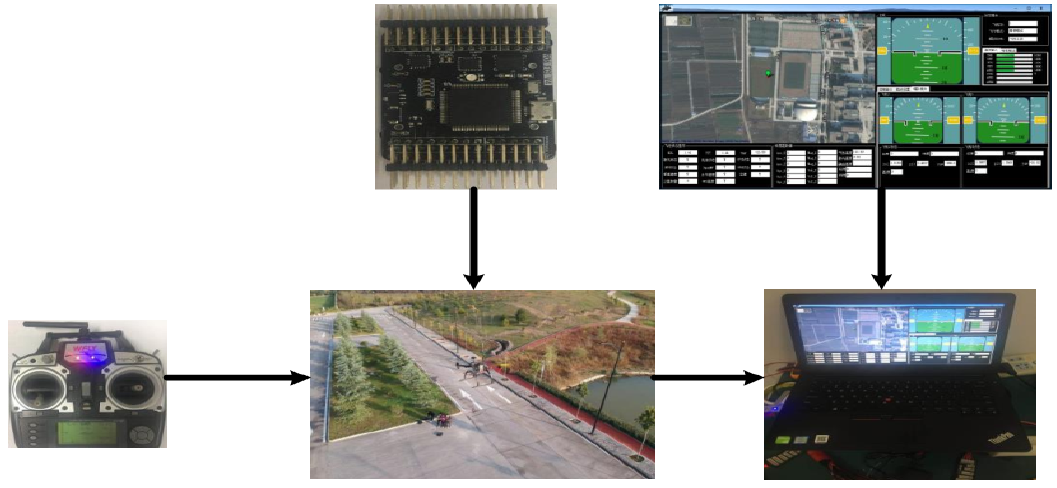
Figure 18. UAV hardware system.